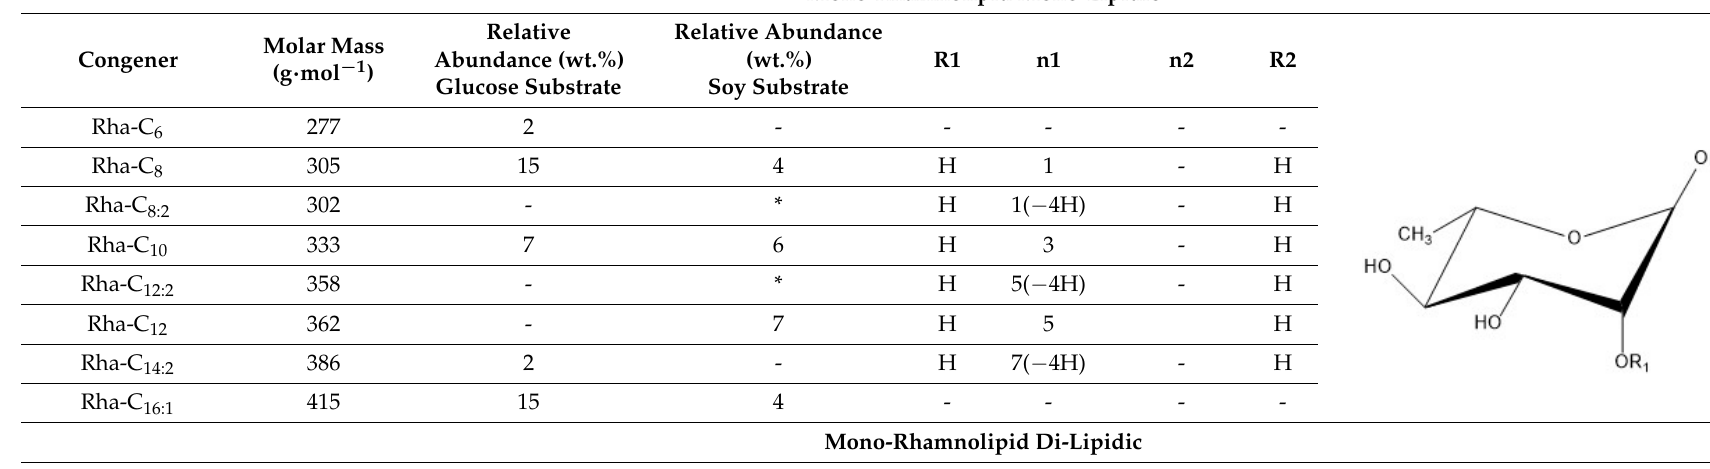
Table 1. Rhamnolipid congeners produced by Pseudomonas aeruginosa using either glucose or soy as a carbon source [145]. The length of the tails is indicated by the first subscript number, while the second subscript number indicates the degree of unsaturation. For example, C 12:2 indicates a tail 12 carbon atoms long with two degrees of unsaturation.